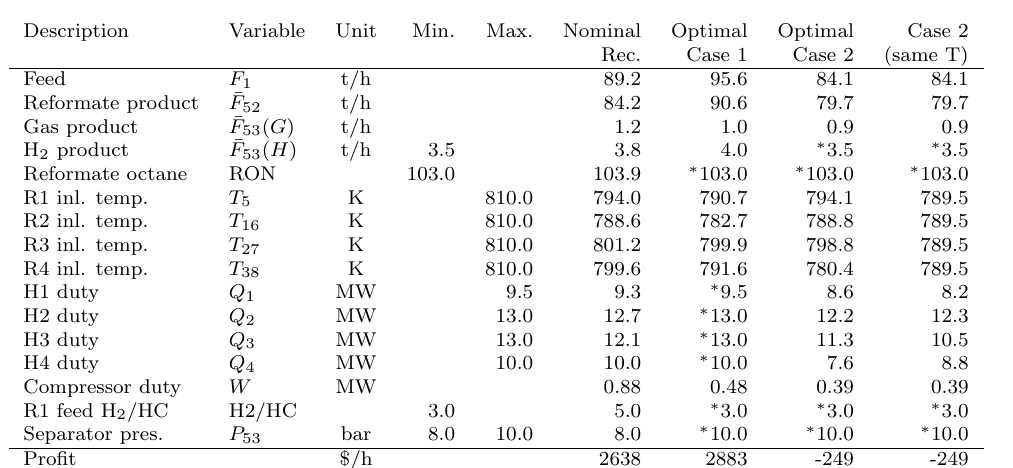
Table 8: Optimal operation with conditions from data set 12 ( ∗ = active constraint)